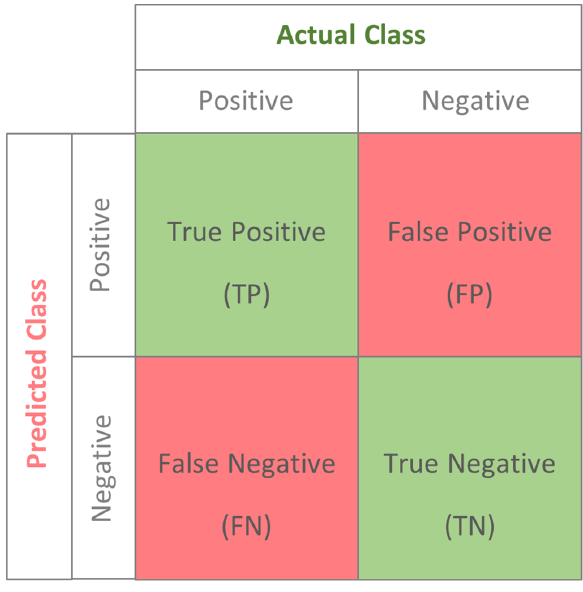
Fig. 6. Confusion